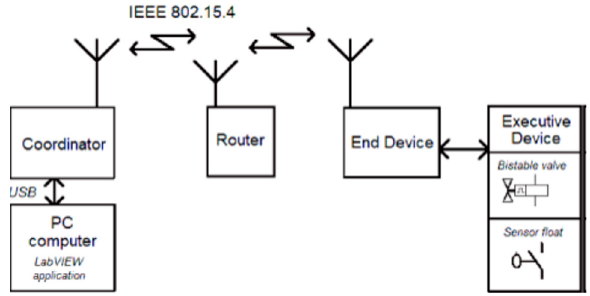
Figure 6. Control device in ZigBee wireless network.